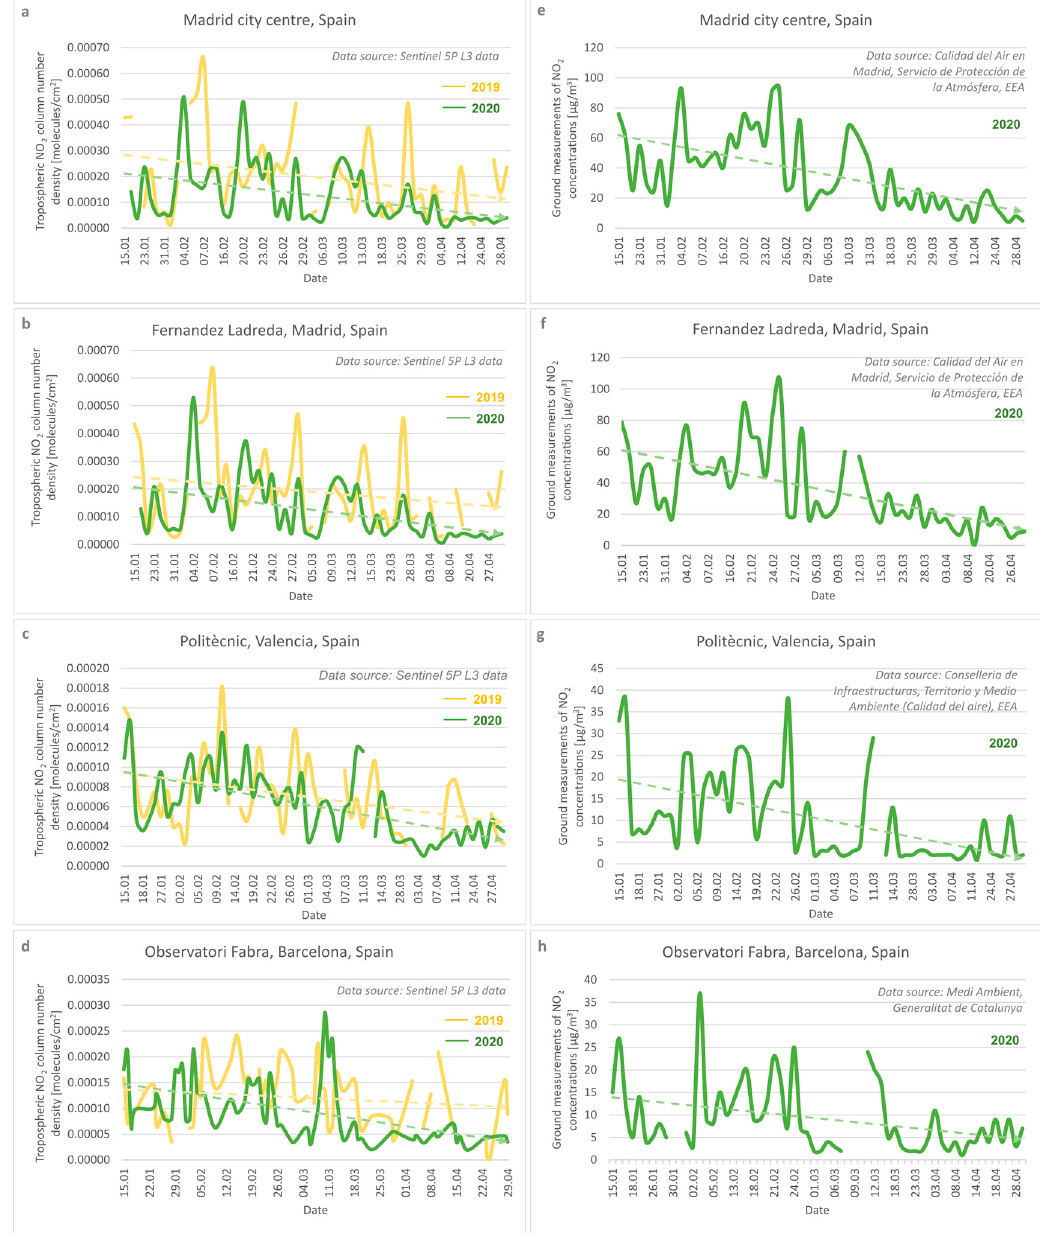
Figure 6. Comparative dynamics of NO 2 daily values for the period between 15 January and 30 April for several Spanish cities, based on clear-sky TROPOMI (TROPOsferic Monitoring Instrument) data in 2019 and 2020 ( a – d ) and ground-based measurements in 2020 ( e – h ).